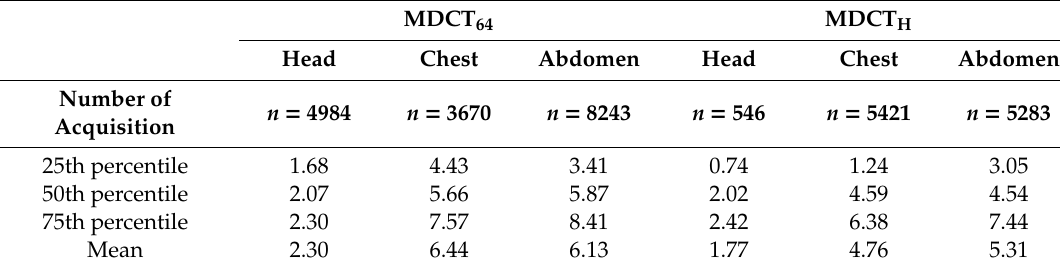
Table 3. E ff ective dose (mSv) from consecutive adult CT